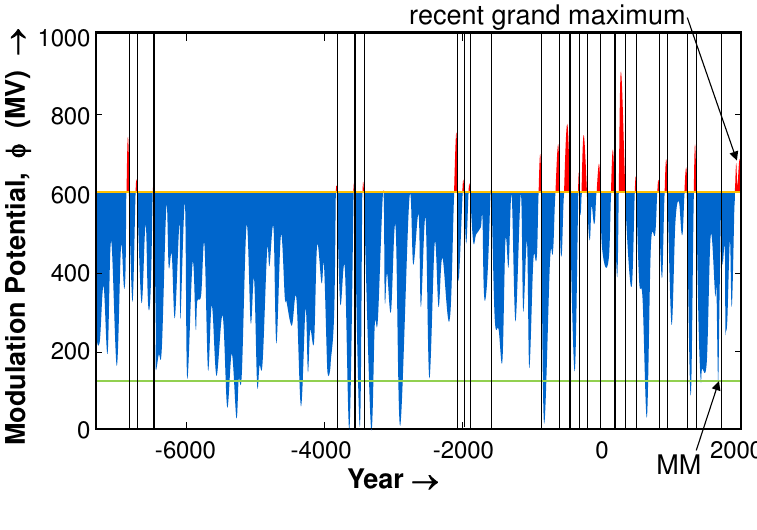
Figure 36: The composite record of 25-year means of the solar modulation potential, 𝜑 25 derived from 10 Be cosmogenic isotope abundances by Steinhilber et al. (2008). The red areas show Grand Solar Maxima (GSM) defined here as when 𝜑 25 exceeds the 600 MV level (the horizontal orange line) the blue areas are where 𝜑 25 is less than this value. The vertical lines show the end times of these GSM, 𝑡 𝑜 . The Maunder minimum is marked MM and the minimum value of 𝜑 25 during it, 𝜑 MM , is marked by the horizontal green